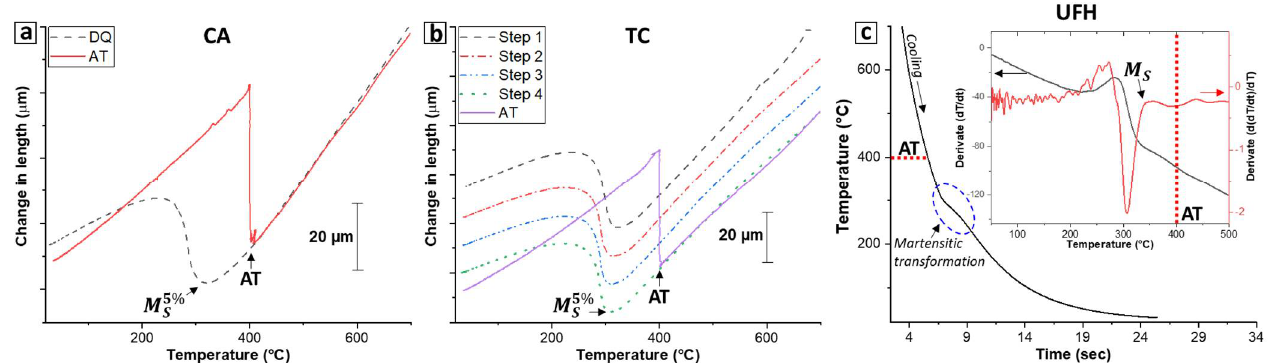
Figure 2. Dilatometric curves obtained during the cooling step, i.e., after the annealing treatments for samples ( a ) CA and ( b ) TC. ( c ) Temperature profile obtained during cooling for the ultrafast heated sample; the insert in ( c ) shows the estimation of the M S temperature via differentiation of the recorded cooling curve.